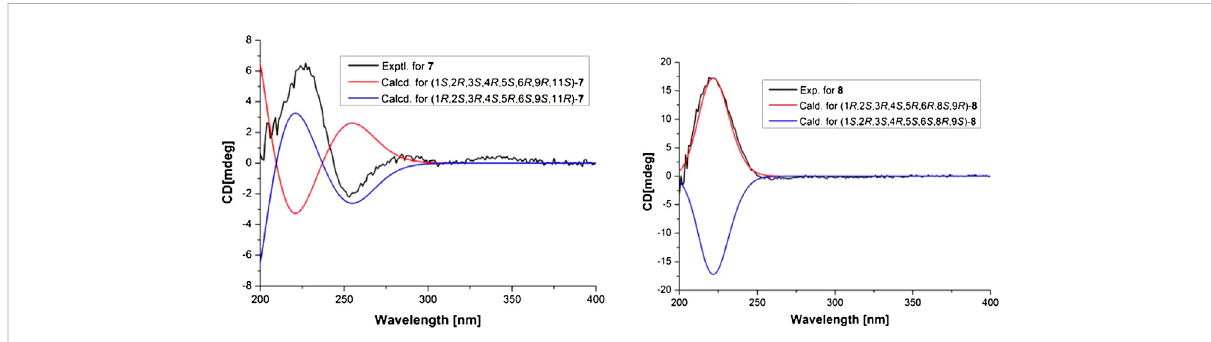
FIGURE 7 Comparison between calculated and experimental ECD spectra of 7 and 8